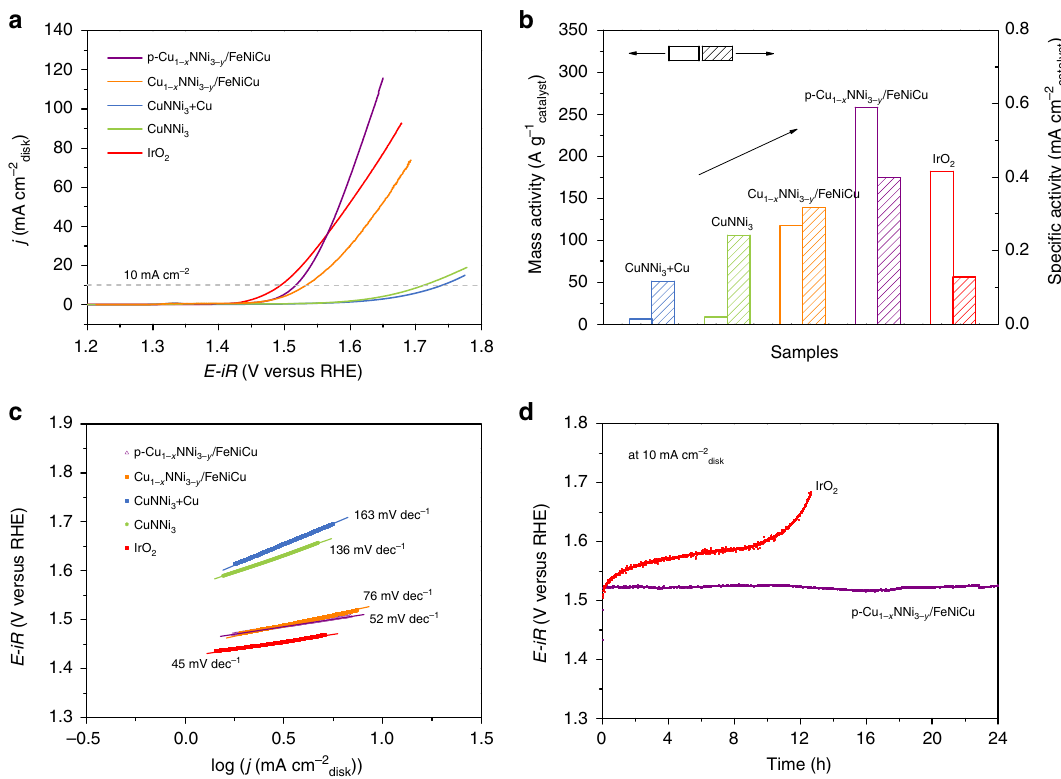
Fig. 5 Electrochemical properties of catalysts. a Ohmic resistance-corrected OER activity curves of the IrO 2 , CuNNi 3 + Cu, p-Cu 1 − x NNi 3 − y /FeNiCu, CuNNi 3 and Cu 1 − x NNi 3 − y /FeNiCu catalysts in 1 M KOH at 5 mV s − 1 . b Mass activities and BET surface area-normalized intrinsic activities of catalysts at η = 400 mV derived from a . c Tafel plots obtained from the steady-state measurements. d Chronopotentiometric curves of p-Cu 1 − x NNi 3 − y /FeNiCu and commercial IrO 2 at 10 mA cm − 2